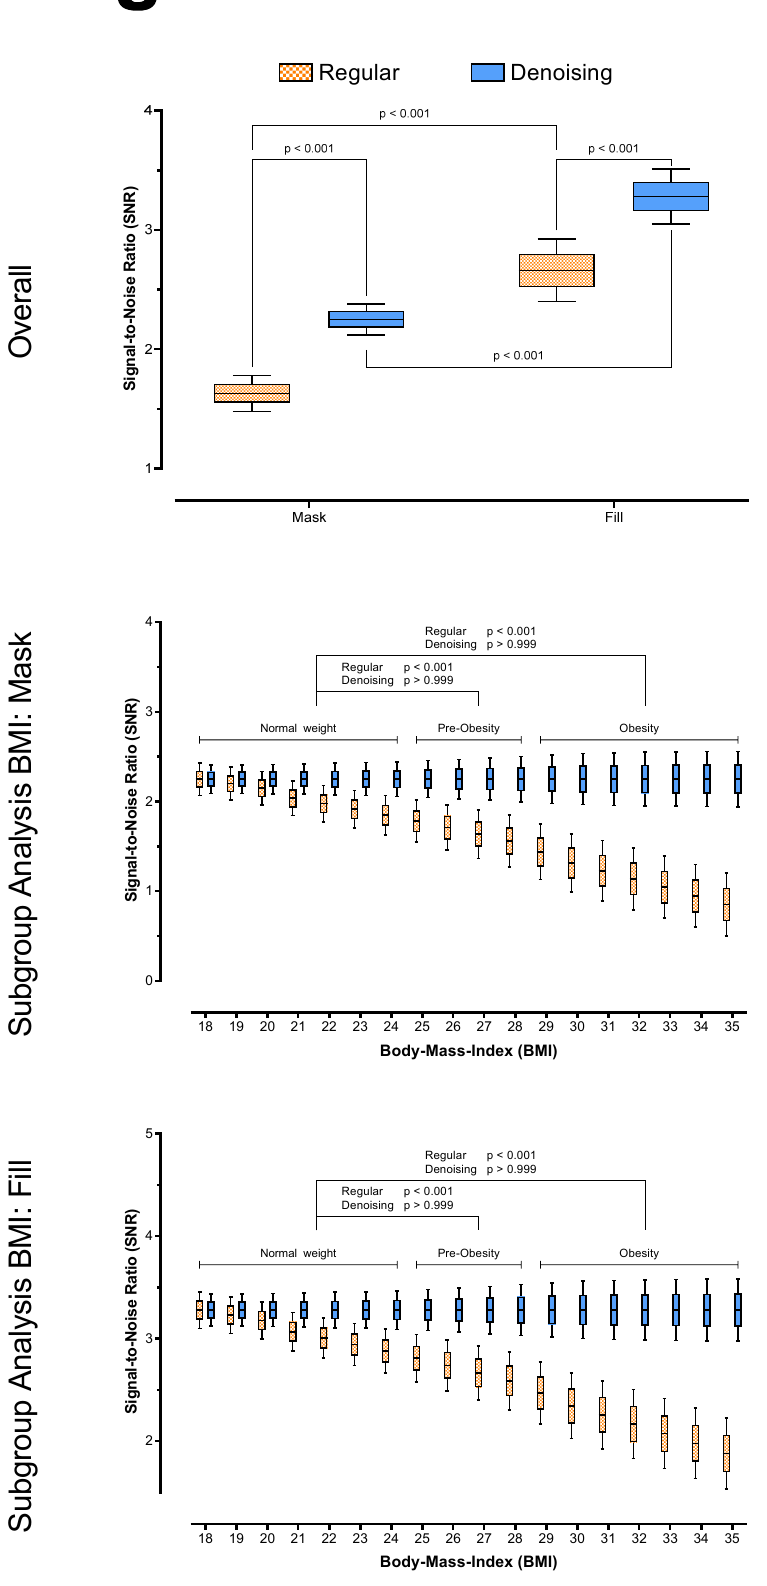
Figure 5. Signal-to-Noise Ratio (HU/SD), overall and posthoc subgroup analysis for patient BMI.